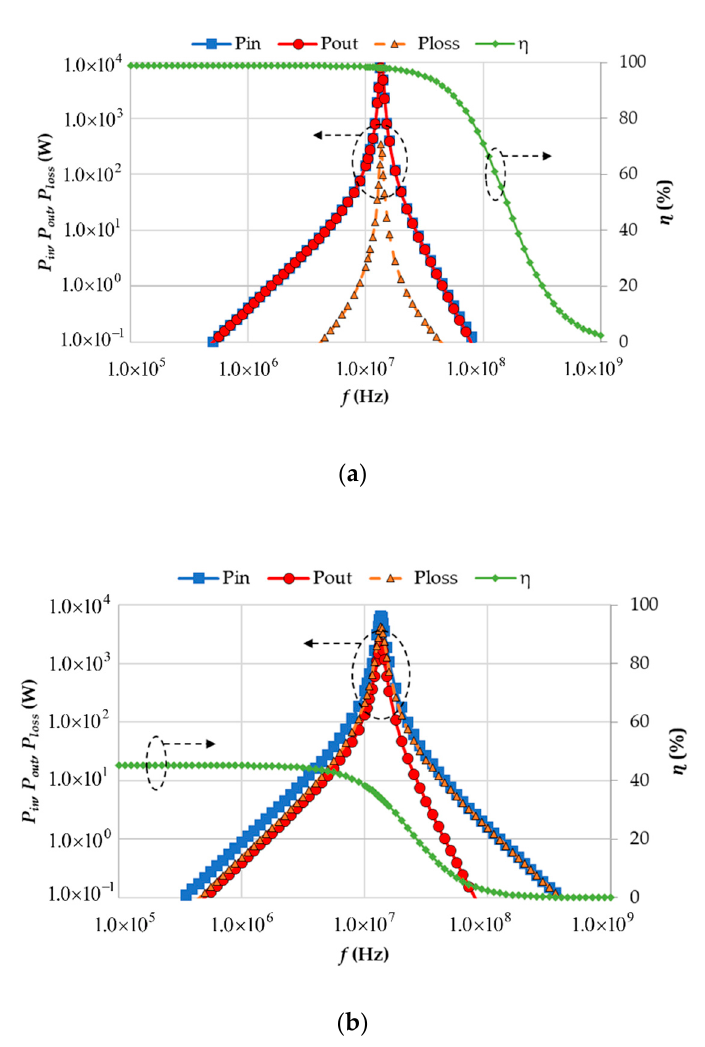
Figure 14. Frequency responses of power and efficiency: ( a ) Lower ESR value; ( b ) Higher ESR value.